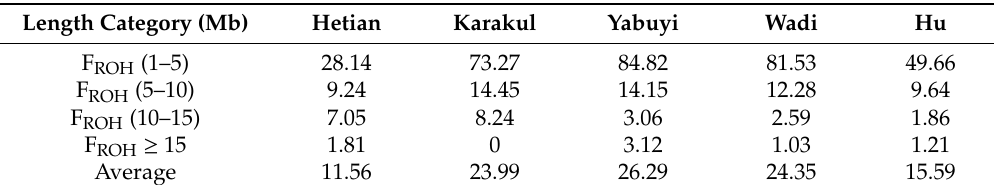
Table3. SummaryofROHsegmentsproportionsatdi ff erentlengthcategoriesacrossfiveChinesebreeds.